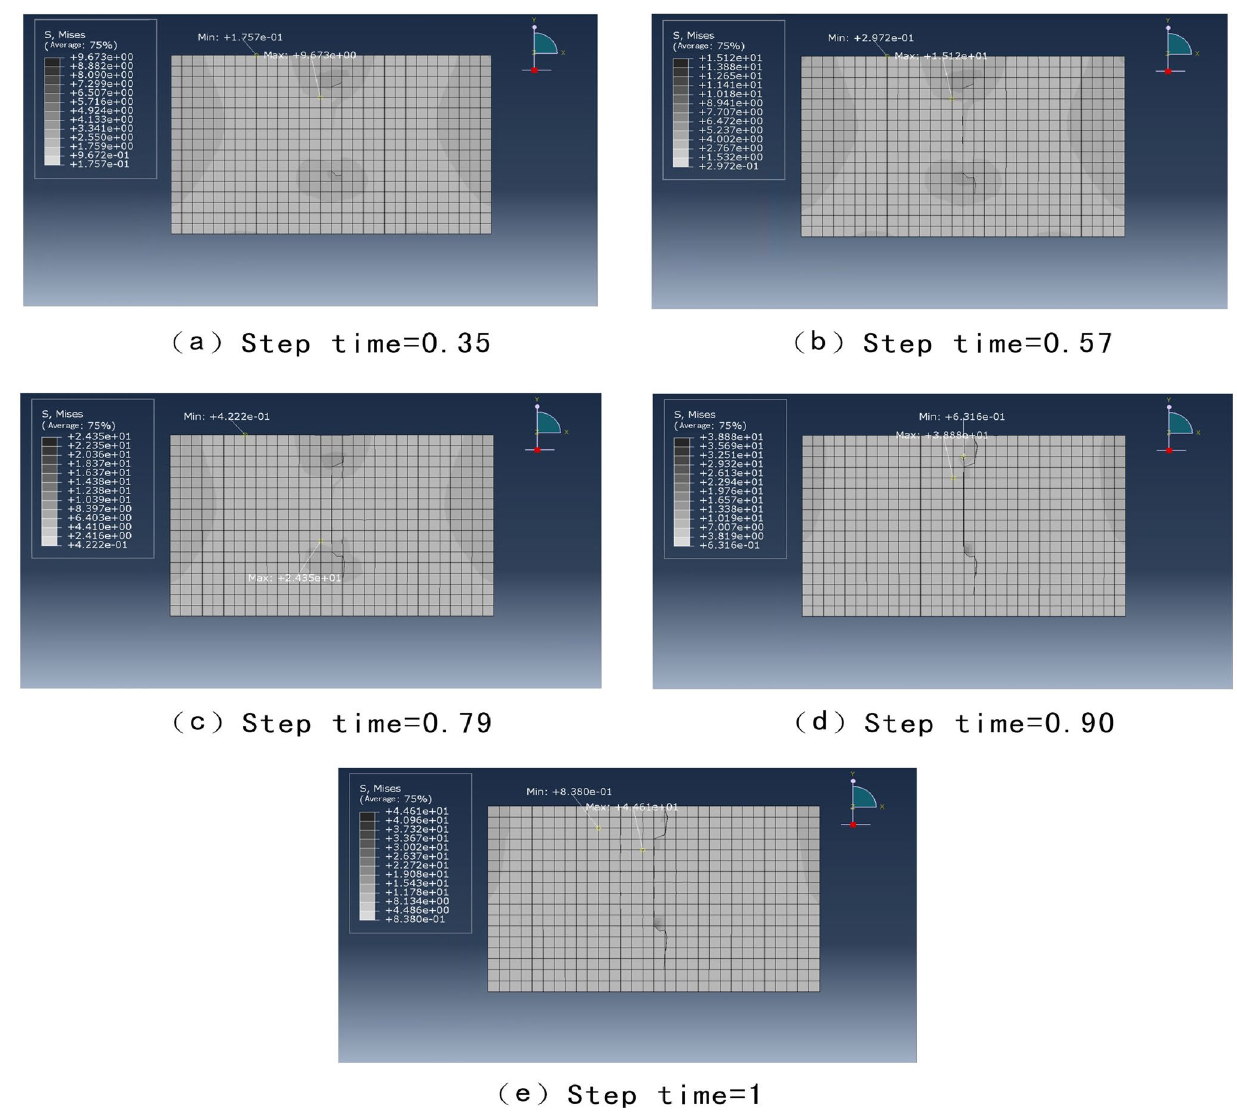
Fig. 6 Stress response phase diagram of dry shrinkage type